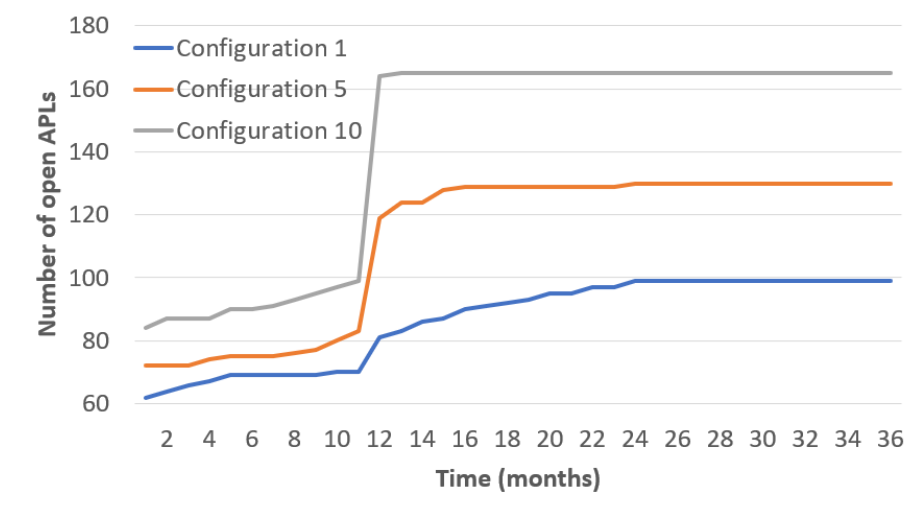
Figure 9. Number of total open APLs along the planning horizon for three configurations ( k = 1, 5,